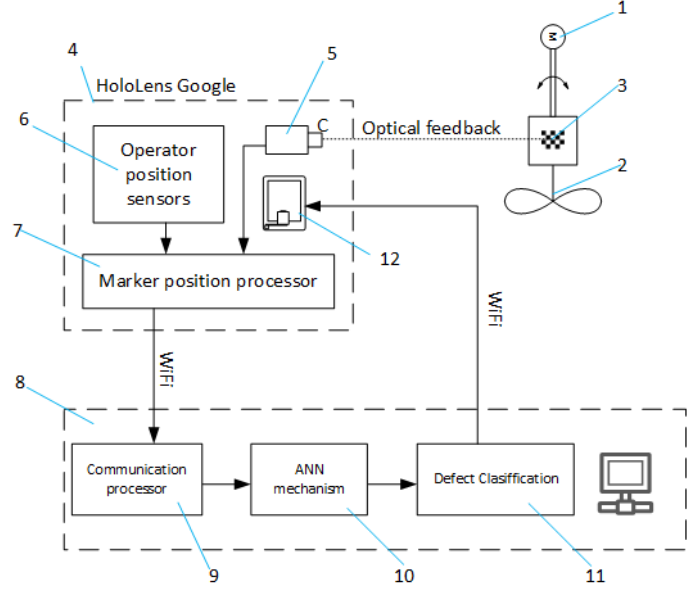
Figure 14. Scheme of the